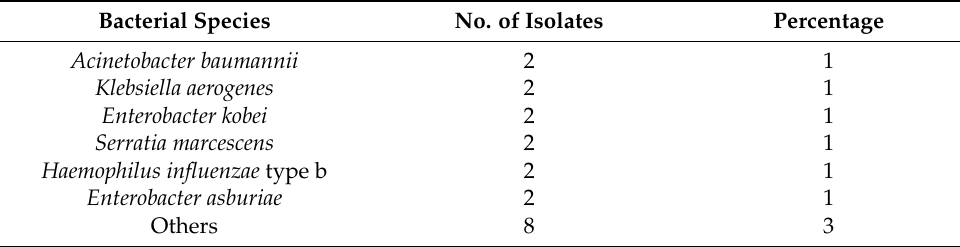
Table 1. Cont . Bacterial Species